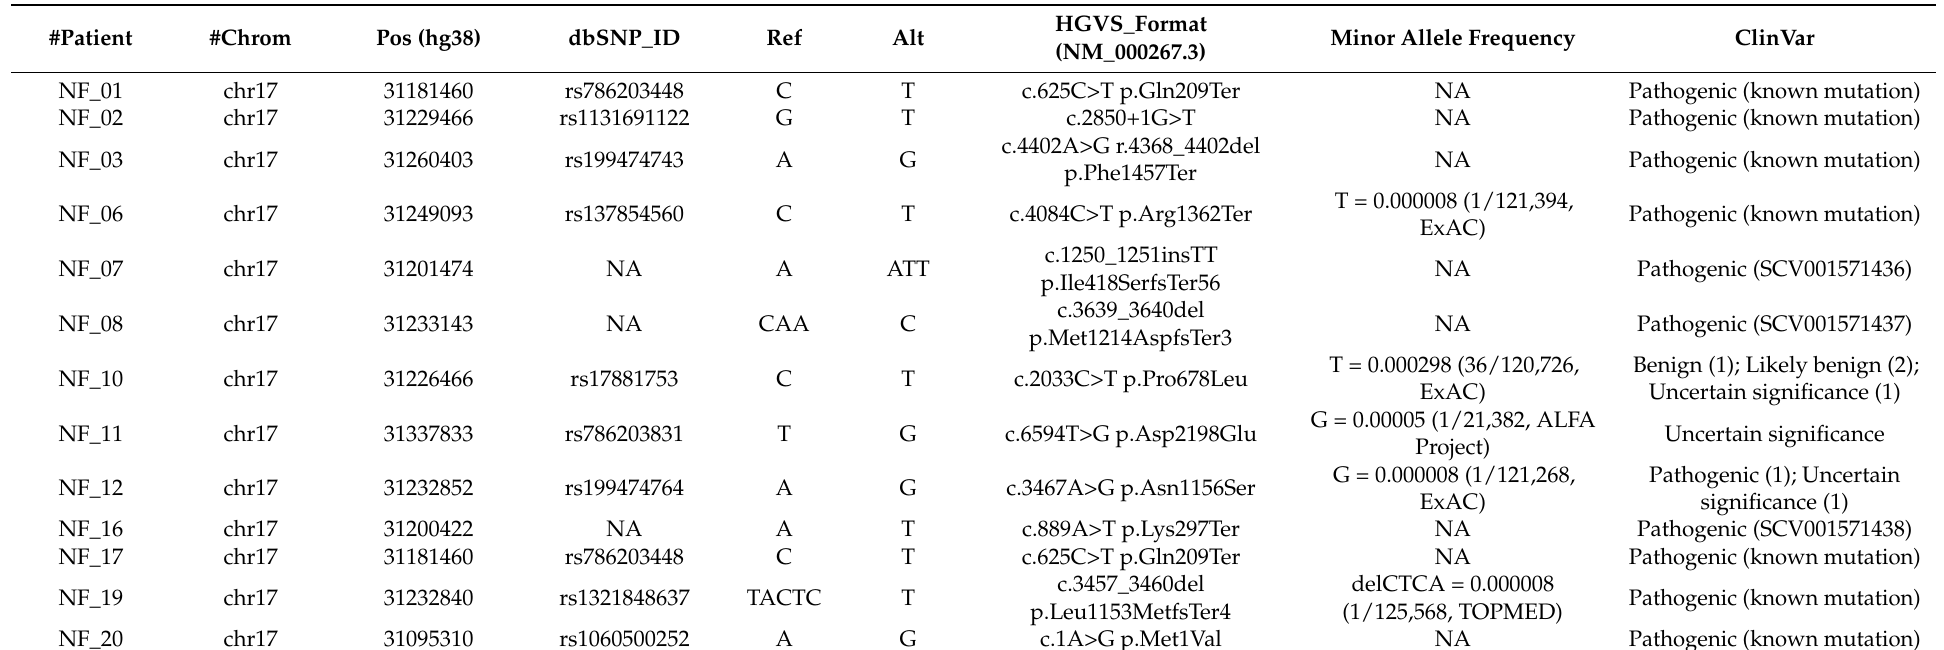
Table 3. Summary of the detected NF1 variants.